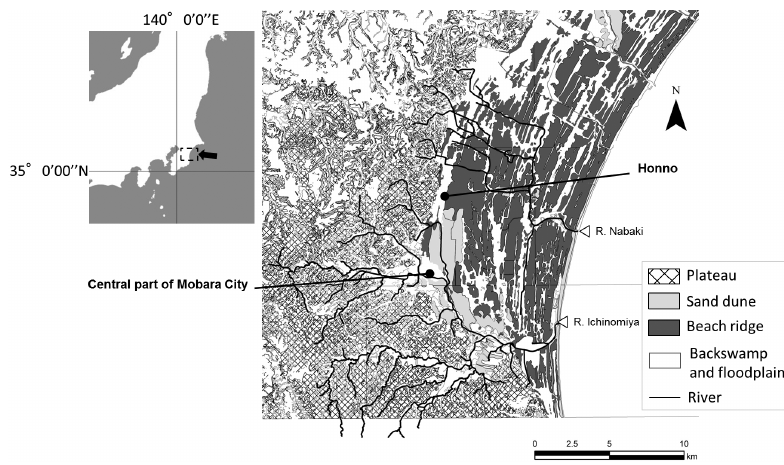
Figure 1. Geomorphological map of the Kujukuri Plain. Study area is Nabaki and Ichinomiya Rivers watershed.